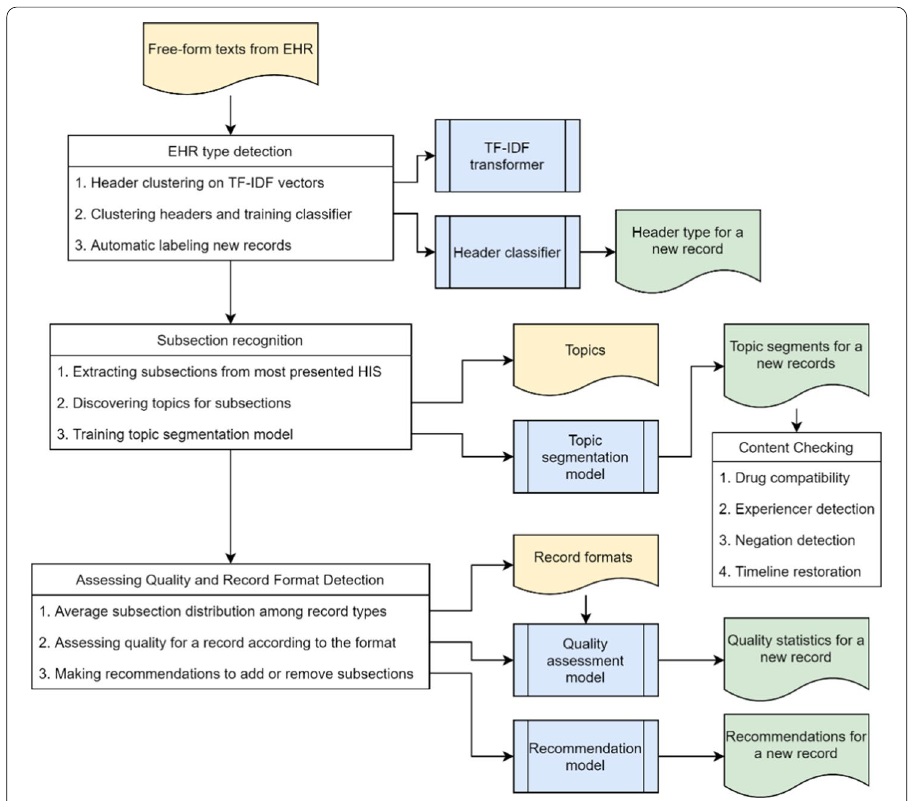
Fig. 4 Diagram of methods to detect and estimate record